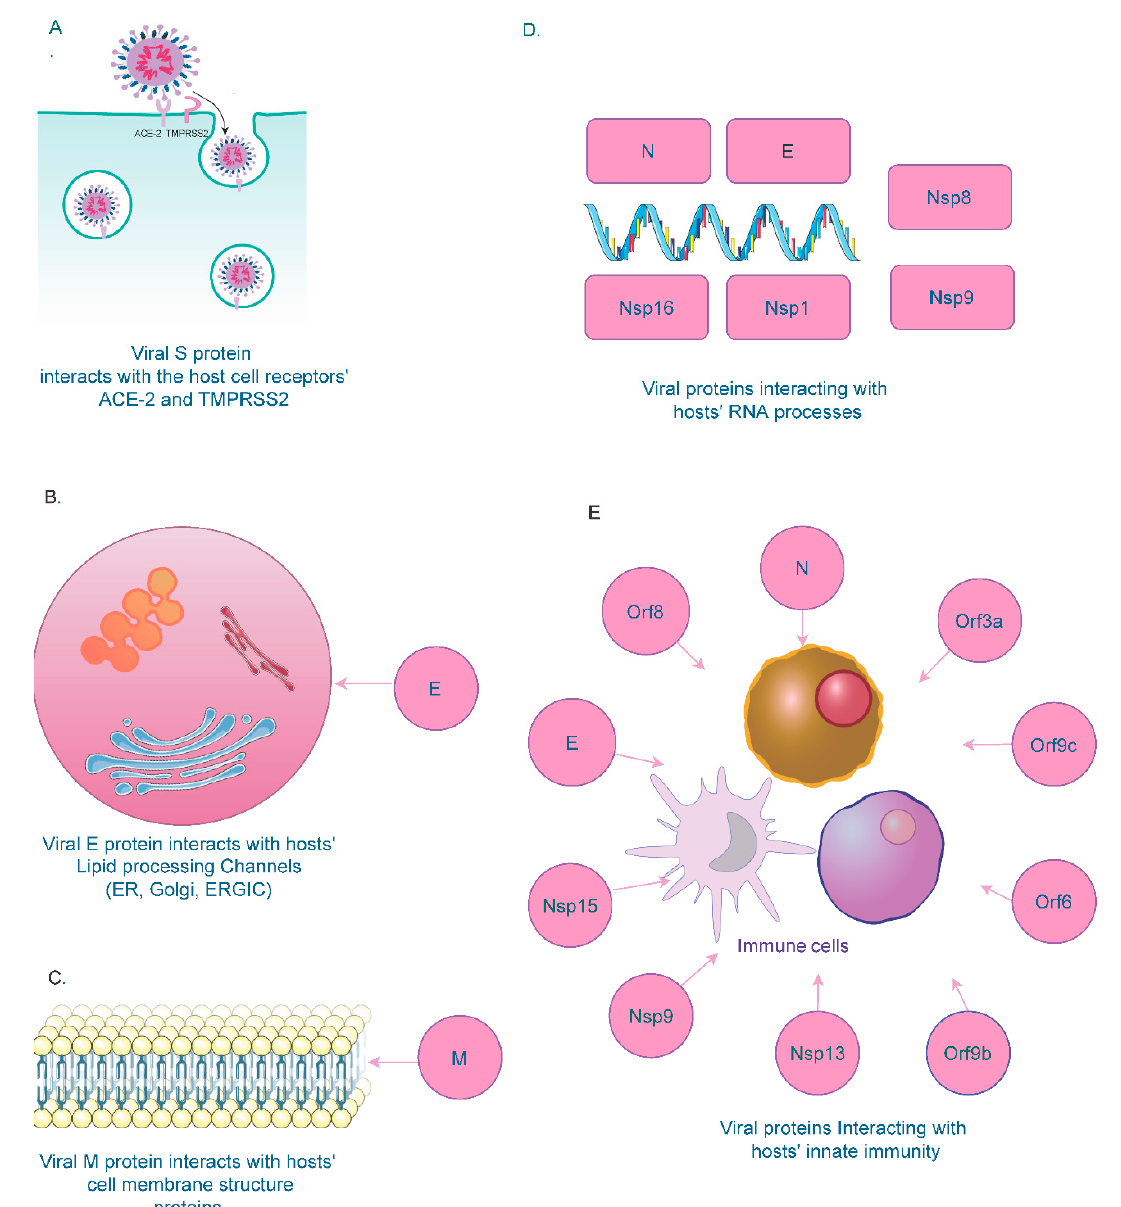
Figure 1. SARS-CoV-2s viral protein interactions with host cell structures and processes. ( A ) SARS-C0V-2 spike (S) protein interacts with host cell receptors ACE2 and TMPRSS2 for cellular entry. ( B ) Host cell membrane structure proteins interact with SARS-CoV-2 membrane (M) proteins for viral morphogenesis. ( C ) Host cell lipid processing channels such as ER, Golgi, and ERGIC interact with the SARS-CoV-2 Envelope ( E ) protein. ( D ) Host RNA processing components interact with SARS-CoV-2 N, E and Nsp (1,8,9,16), encoded by the SARS-CoV-2 genome. ( E ) Several structural and non-structural proteins in the SARS-Co-V-2 genome interact with components of the host innate immune system.